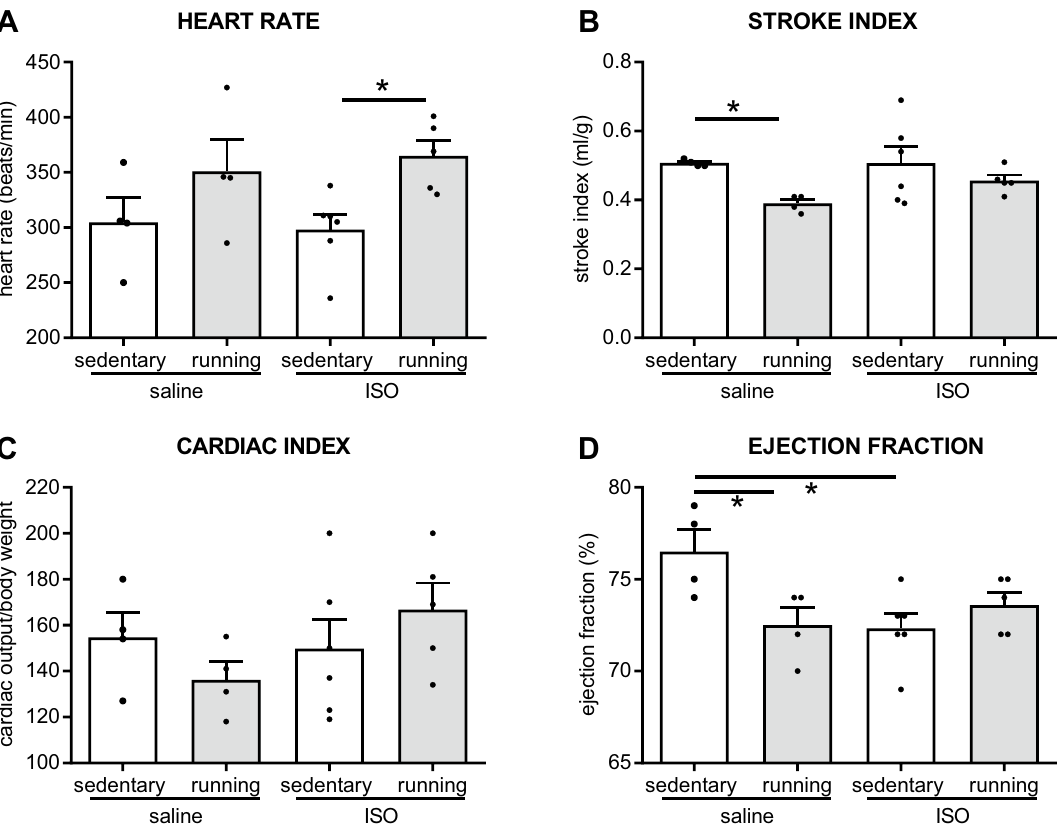
Figure 2. Echocardiographic measures of cardiac function in saline or isoproterenol (ISO) treated rats, under sedentary conditions or after five weeks of exercise training, (n = 4, 4, 6, 5 for saline sedentary, saline exercise, ISO sedentary and ISO exercise rats, respectively). *: significant difference between groups ( p < 0.05); + : tendency (ANOVA p = 0.089; subsequent post-hoc test <